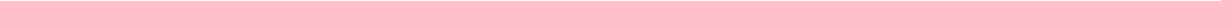
Fig. 3 A transposon-based biosensor screen to identify PARylated proteins. a A genetic screen to identify PARylation events. (i) UPATrap-VC was introduced into CAL51 cells, generating six tagged cell libraries (5000 clones each). (ii) Either PBZ-GF, PBZ-VN, or PBZ-4A-VN biosensors were introduced into each library and GFP-positive cells were isolated (iii); PBZ-GFP showed 60% GFP-positive cells, while the PBZ-VN constructs showed 0.1% GFP-positive cells. (iv) Genomic DNA was isolated from GFP-positive cells and UPATrap-VC integration sites identi fi ed by non-restrictive linear ampli fi cation PCR (nrLAM-PCR) followed by deep-sequencing. Each gDNA sample was ampli fi ed and sequenced in three independent reactions (A, B, C). b A schematic of the transposon-mediated VC tagging, when an UPATrap-VC transposon is introduced into genes. Yellow triangles Tol2 transposon repeats, SA splicing acceptor, SD splicing donor, IRES internal ribosome entry site, NeoR G418-resistance gene, pA polyAdenylation signal. Integration of UPATrap-VC into genes results in the production of protein-VC fusion proteins and NeoR protein. c Integration of a full-length GFP version of UPATrap (UPATrap-GFP) generates speci fi c localization pattern in different GFP-positive colonies. This suggests that the transposon has captured and generated in- frame protein-VC fusion in a speci fi c gene. d nrLAM-PCR and deep-sequencing from independent reactions is highly reproducible. Scatter plots are shown illustrating the correlation between unique read depth from three replica nrLAM-PCR and sequencing reactions (A, B, and C); Spearman ’ s rank correlation > 0.98. e Distribution of sequencing depth across all libraries in the screen. Approximately 50 genomic sites were represented by a unique read depth of > 30 reads (see detailed description in methods). f A schematic representation of the three genes identi fi ed with two, independent, transposon integration sites (indicated by red circles). g Biosensor signal obtained by the expression of full-length NPM1-VC and CTIF-VC in combination with PNZ-VN. The cells were co-stained with antibodies, recognizing the endogenous NPM1 and CTIF, respectively. h PARylation biosensor screen detects “ hits ” with different subcellular localization. Confocal imaging of VC-VN GFP signal for 11 genes identi fi ed in the screen are shown. NPM1 is a known PARylation target. Scale bars represent 5 µ